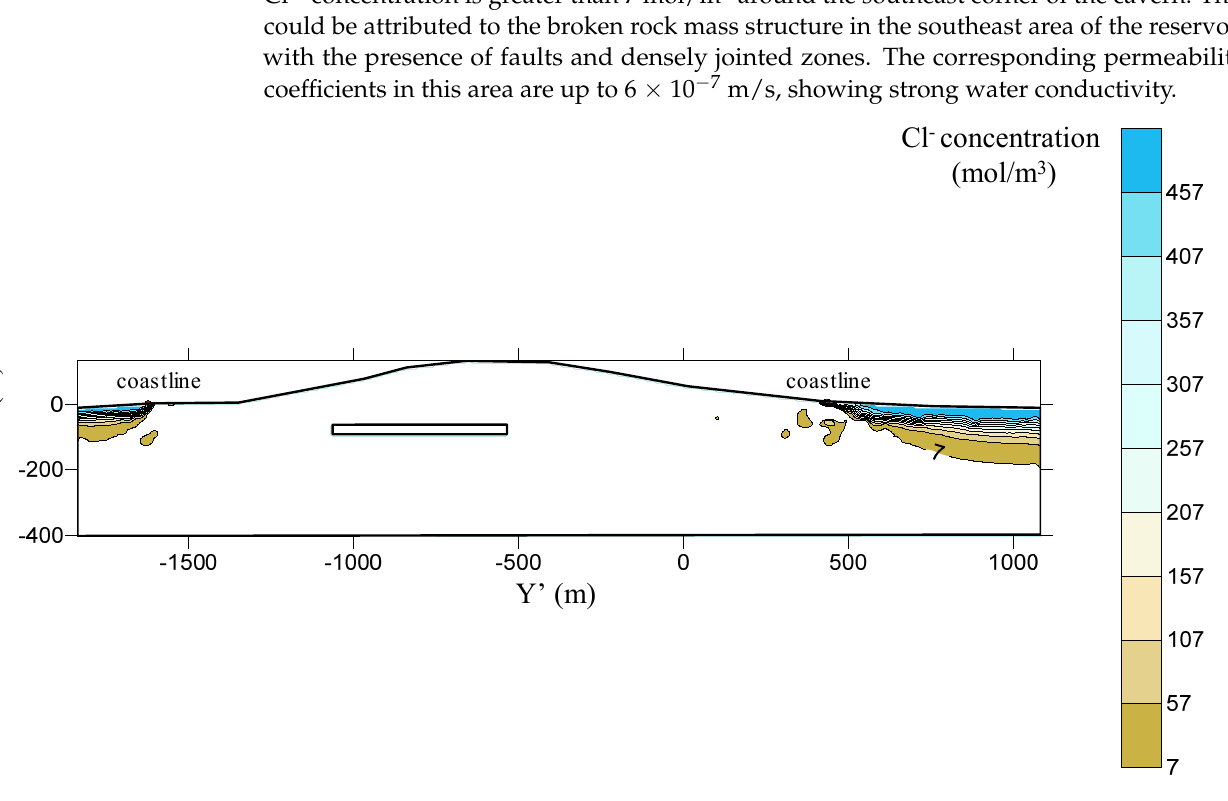
Figure 14. Cl − concentration contour map of Section 2 at the end of cavern construction.